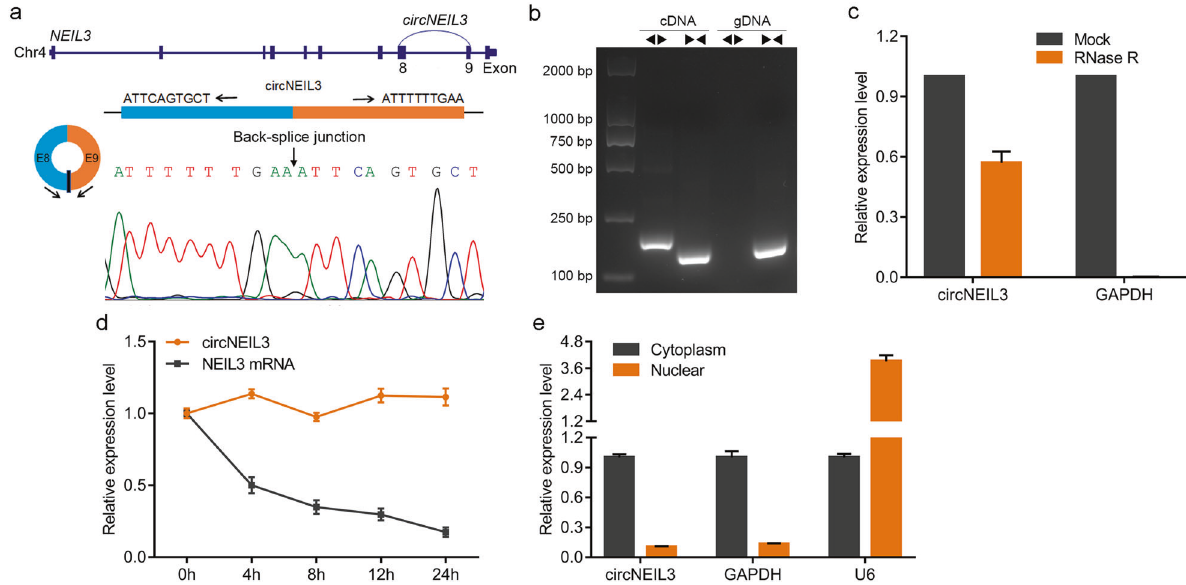
Fig. 2 Characterization of circNEIL3 in LUAD cells. a Genomic location of circNEIL3. The back-spliced junction of circNEIL3 identi fi ed using Sanger sequencing. b PCR analysis for circNEIL3 in complementary DNA (cDNA) and genomic DNA (gDNA). c Relative levels of circNEIL3 and GAPDH detected using RT-qPCR after RNase R digestion, normalized to the value detected in the mock group. d RT-qPCR for the abundance of circNEIL3 and NEIL3 in A549 cells treated with actinomycin D at the indicated time points. e Levels of circNEIL3 in the cytoplasmic and nuclear fractions of A549